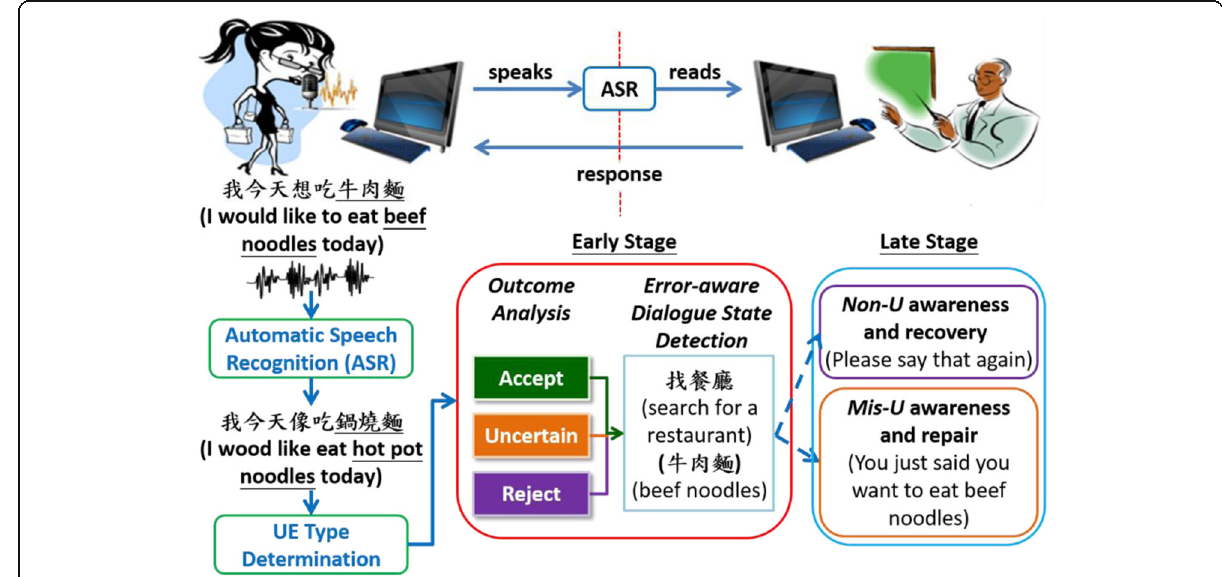
Fig. 3 The WoZ framework for miscommunication corpus